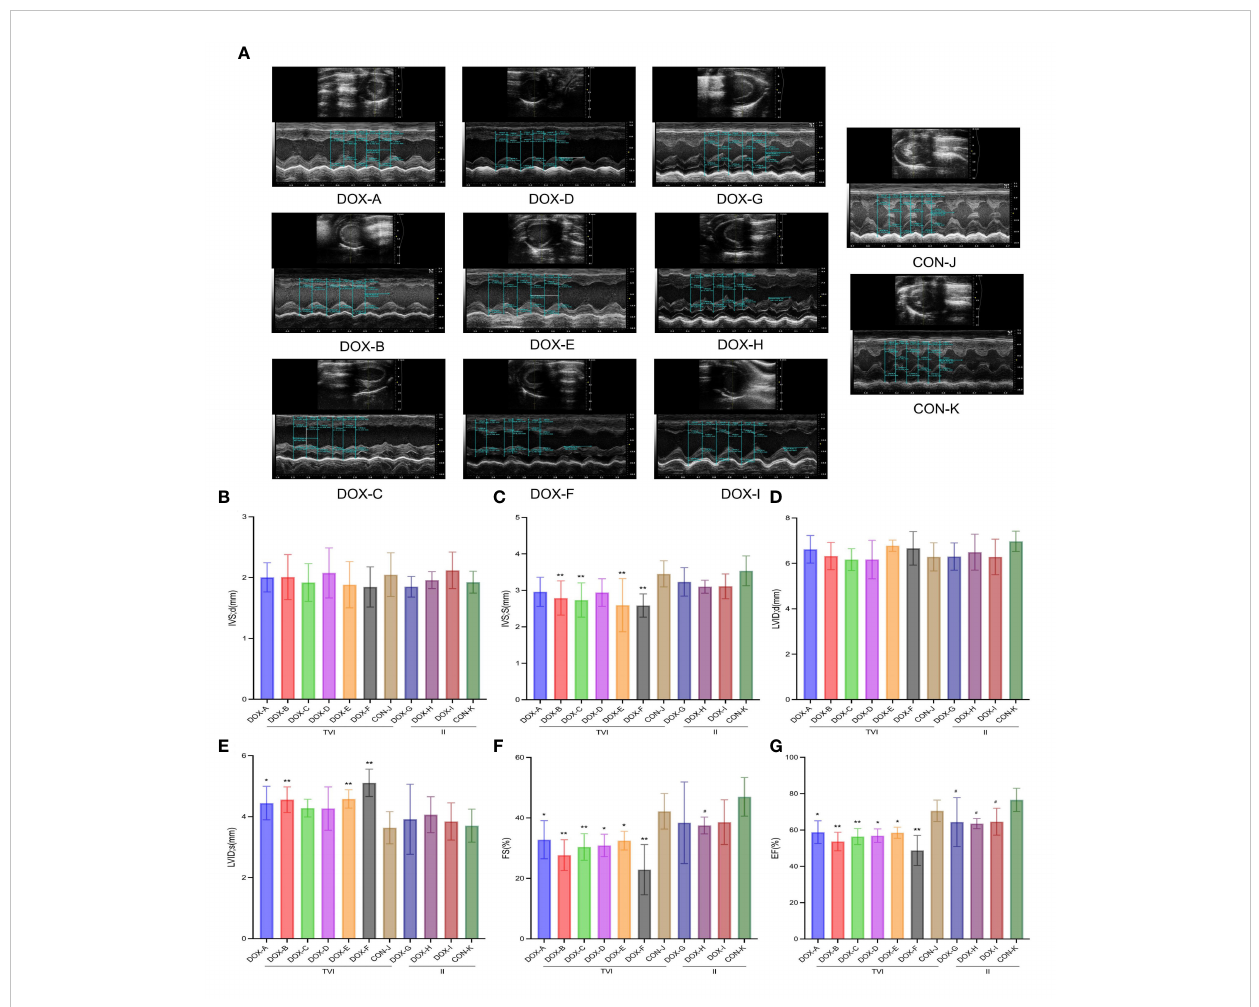
FIGURE 3 DOX-induced cardiac dysfunction and histological injury. (A) Representative echocardiograms. (B – G) Comparison of echocardiography parameters. LVID;d, left ventricular internal diameter at end-diastole; LVID;s, left ventricular internal diameter at end-systole; IVS;d, interventricular septal thickness at end-diastole; IVS;s, interventricular septal thickness at end-systole; FS%, left ventricular fractional shortening; EF%, left ventricular ejection fraction. CON, control; DOX, doxorubicin. *P < 0.05, **P < 0.01 vs. CON-J; #P < 0.05, ##P <0.01 vs.